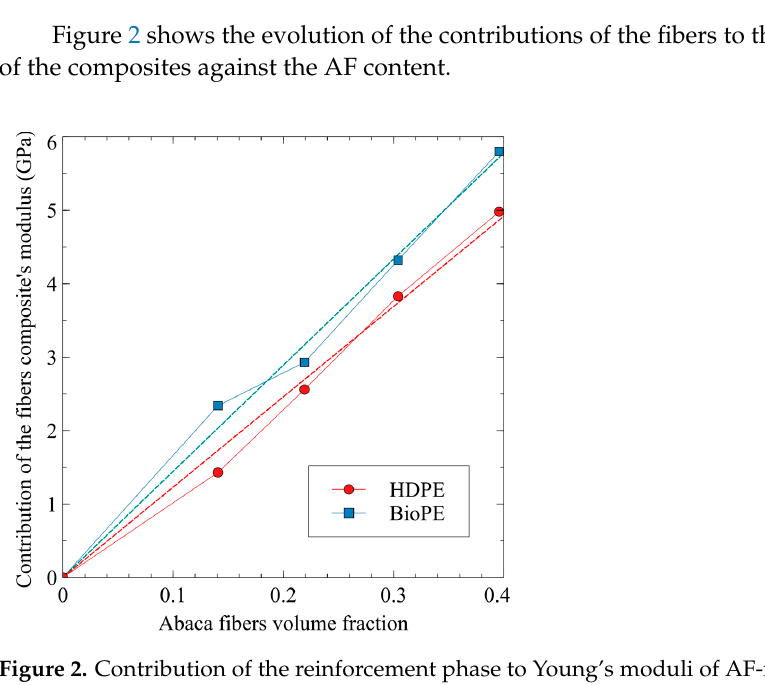
Figure 2. Contribution of the reinforcement phase to Young’s moduli of AF-reinforced HDPE and BioPE composites.